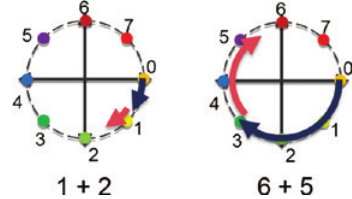
Figure 18: Carry context via adding half-phase.